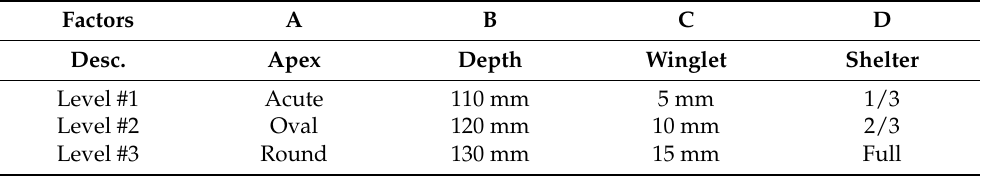
Table 2. Control factors and levels.